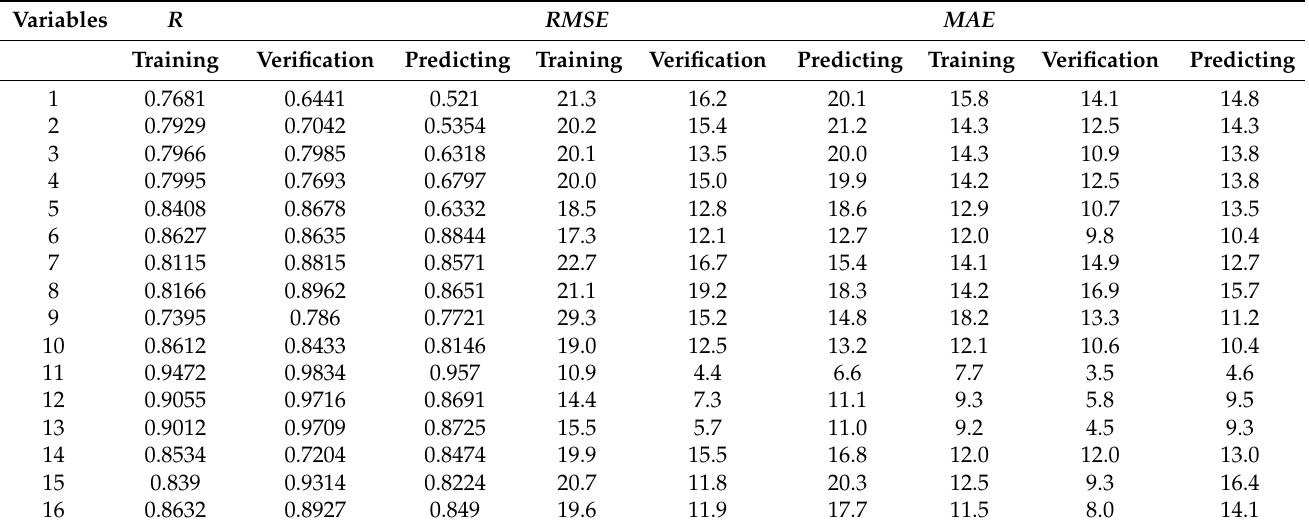
Table 3. Comparison of R , RMSE ( µ g/m 3 ), and MAE ( µ g/m 3 ) between various input variables.